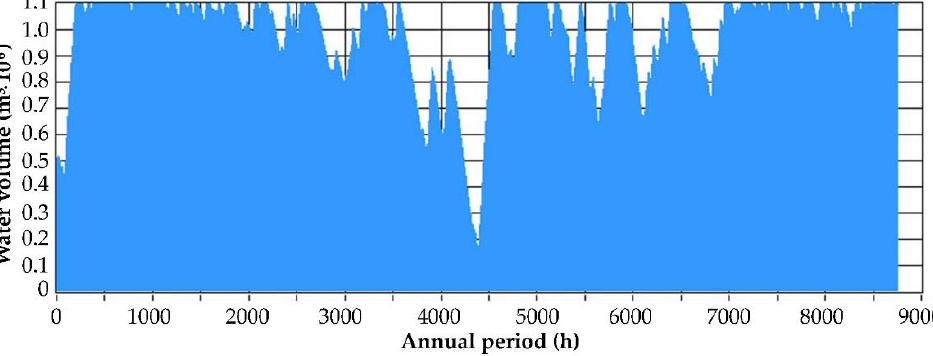
Figure 11. Annual fluctuation of the water volume stored in the PHS system upper reservoir.